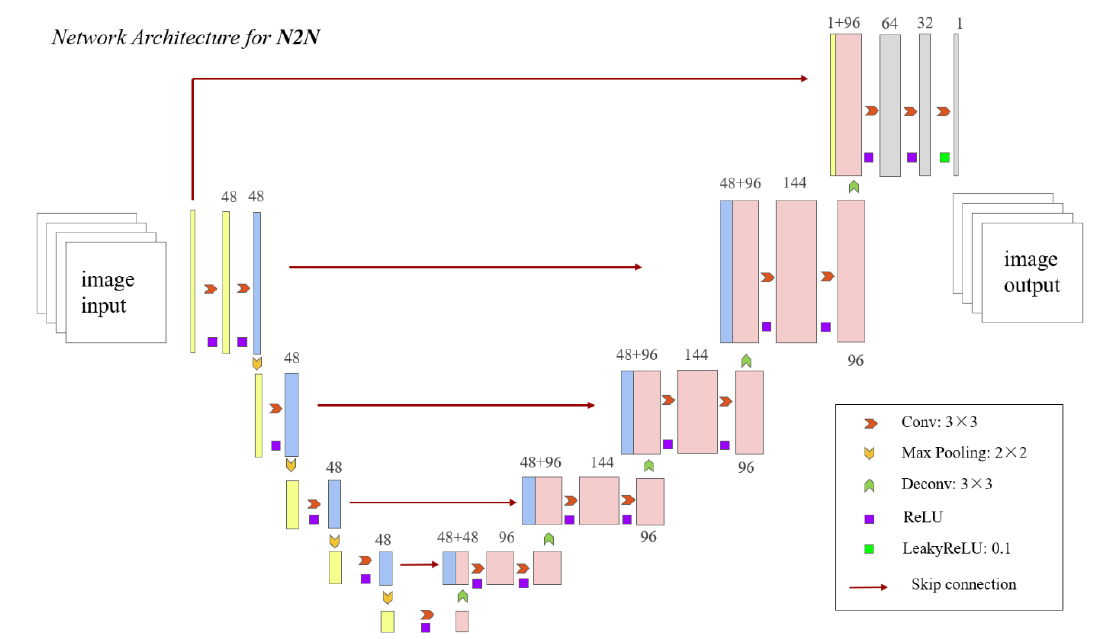
Figure 1. The network architecture of N2N network. Abbreviations: Conv, convolution; Deconv, deconvolution; ReLU, rectified linear unit; LeakyReLU, leaky rectified linear unit.